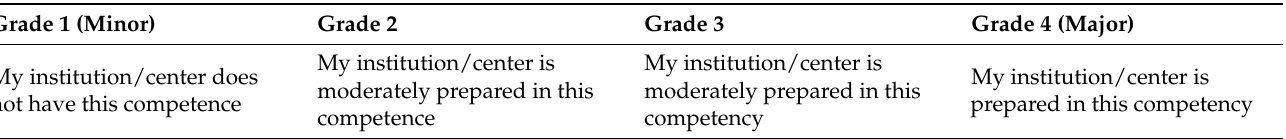
Table A2. Grades for evaluating the competences of the PROF-XX framework.